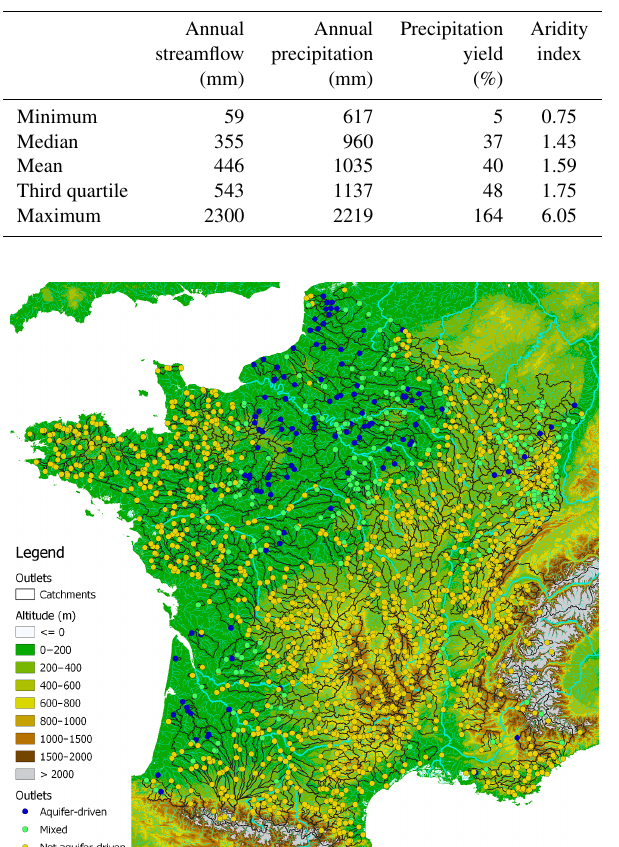
Table 3. Hydrological characteristics of the catchment dataset. The aridity index is defined as the quotient of average rainfall by average PET. NB: precipitation yield greater than 100% was encountered in a small karstic catchment where supplementary water is brought by a major resurgence.